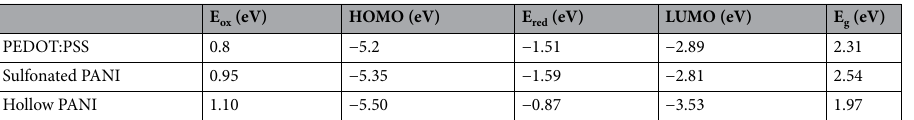
Table 1. Energy levels of PEDOT:PSS, sulfonated PANI and hollow core nanofibers calculated by CV analysis.